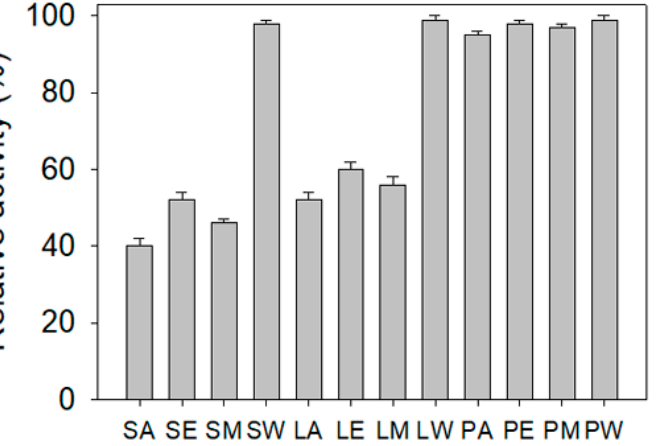
Figure 7. ALLase inhibitory potential. Different extracts of N. miranda (30 µ g/mL) were used for inhibiting the activity of ALLase. S, stem; L, leaf; P, pitcher; A, acetone; E, ethanol; M, methanol; W,